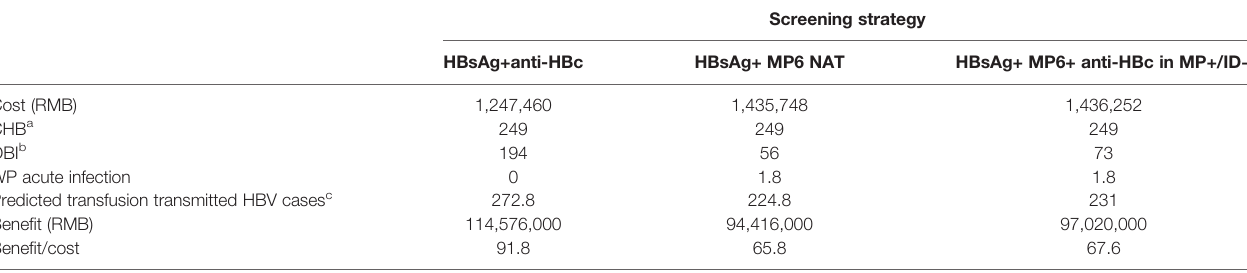
TABLE 4 | Cost-effectiveness analysis of 103,955 donors* in Chinese Shenzhen Blood Center.